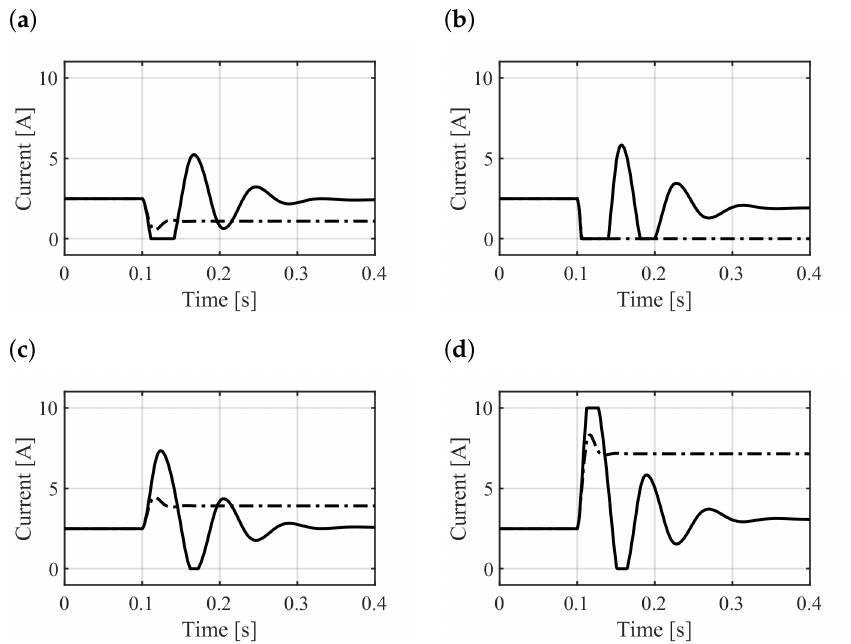
Figure 12. Response of the system with hysteretic (solid) and linearized (dash-dotted) rotor material to external force steps: currents i 0 + i c ( a ) and i 0 − i c ( c ) for the 100-N step amplitude; currents i 0 + i c ( b ) and i 0 − i c ( d ) for the 300-N step